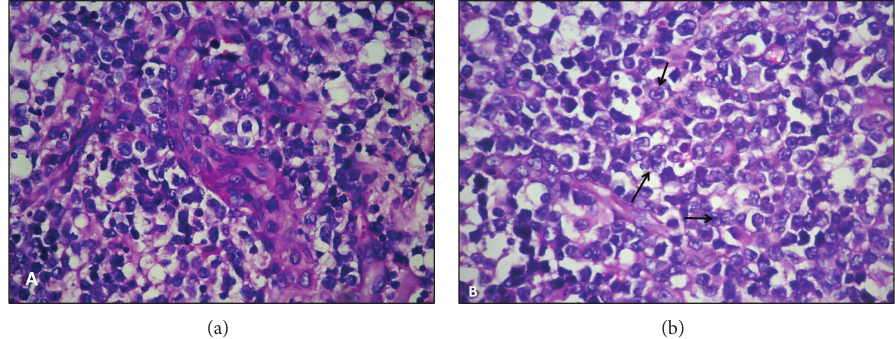
Figure 3: Paraffin embedded tissue sections from the excised left shoulder nodule showing sheets and aggregates of pleomorphic tumor cells with irregular nuclear contour and prominent nucleoli. The tumor cells showed angiocentricity (a) and at places, “embryo”/“horse shoe” like nuclei, prominent nucleoli (so-called “hallmark” cells) ((b), black arrows) (haematoxylin eosin, 400x).